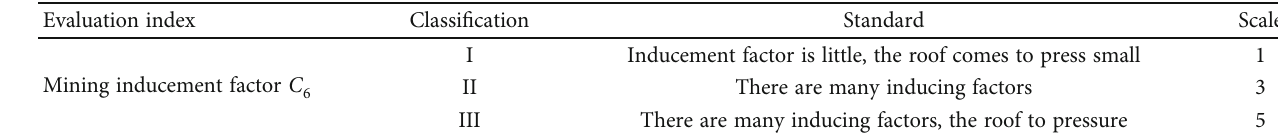
Table 9: Classi fi cation of inducible factors.